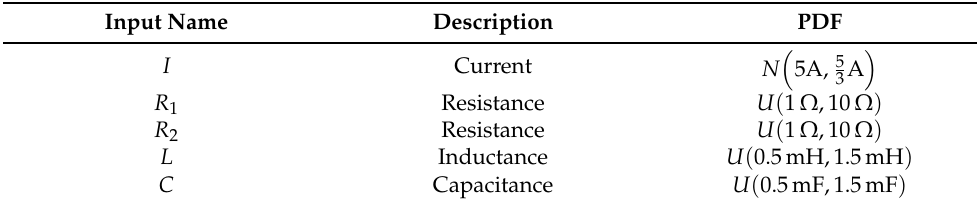
Table 5. Uncertainty characterization of the model inputs. U ( min , max ) denotes a uniform PDF with min and max as extreme values, whereas N ( µ , σ ) denotes a Gaussian PDF with mean µ and standard deviation σ